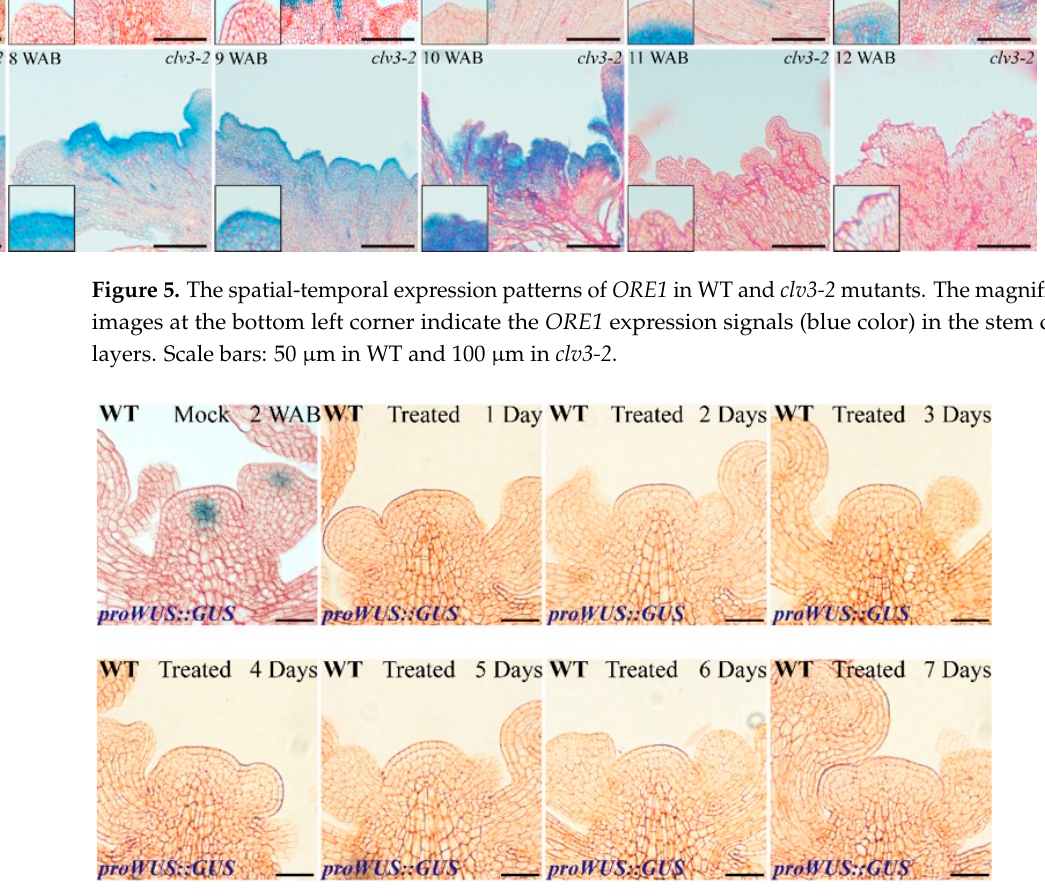
Figure 5. The spatial-temporal expression patterns of ORE1 in WT and clv3-2 mutants. The magni- fied images at the bottom left corner indicate the ORE1 expression signals (blue color) in the stem cell layers. Scale bars: 50 μ m in WT and 100 μ m in clv3-2 .